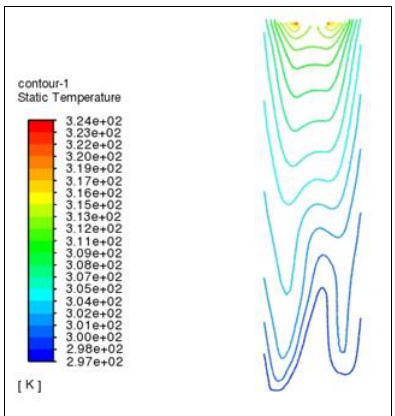
Figure 5. Air isotherm cloud chart.